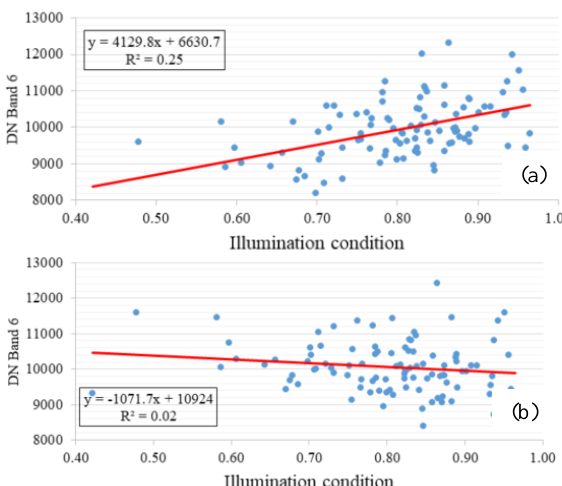
Figure 7. Reflectance of band 5, (a) before and (b) after topographic correction